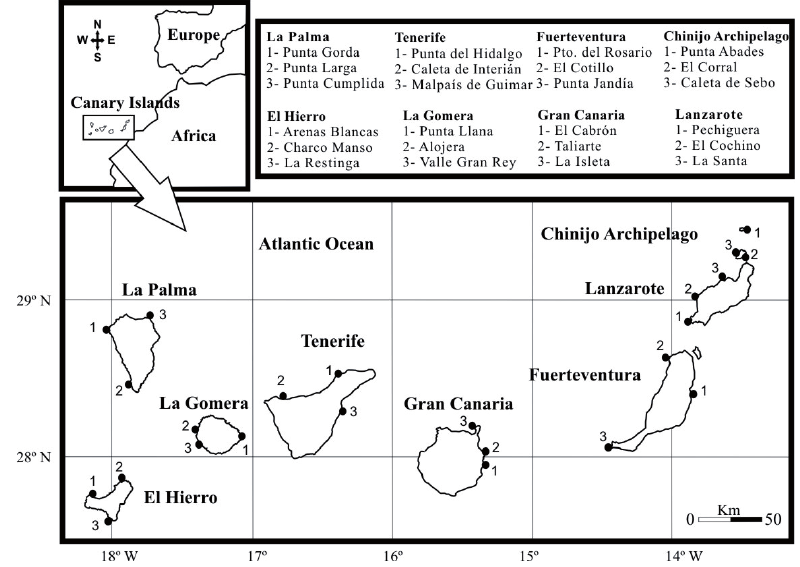
Fig . 1. − map of the sampling localities at each island throughout the canarian archipelago (eastern